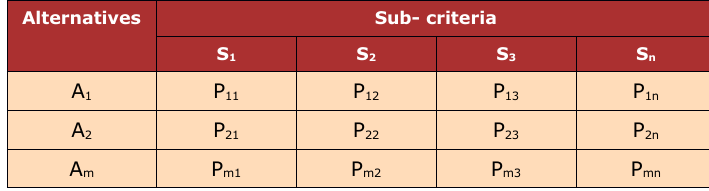
Table 8. Normalized decision